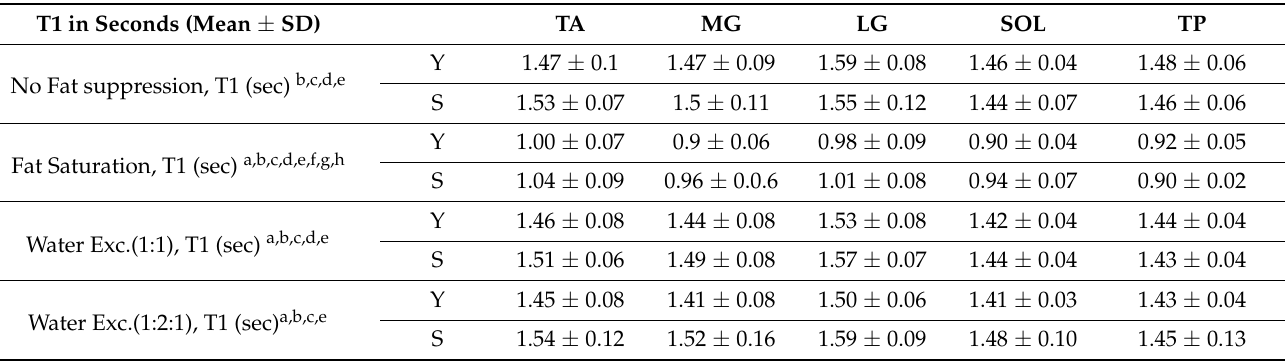
Table 1. T1 using no fat suppression and three fat suppression methods: Regional muscle T1 for young and senior cohorts.